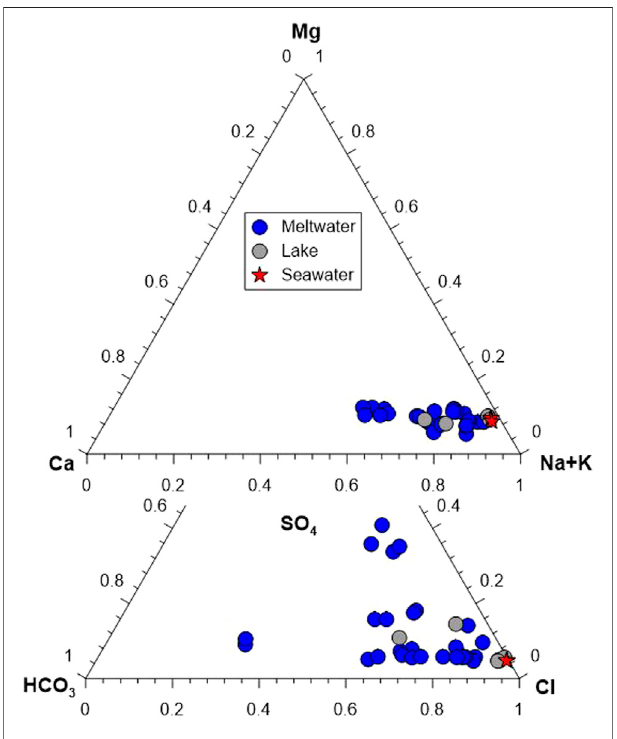
FIGURE2 | Ternary diagrams showing the relative molar abundances of cation and anion in the water samples.